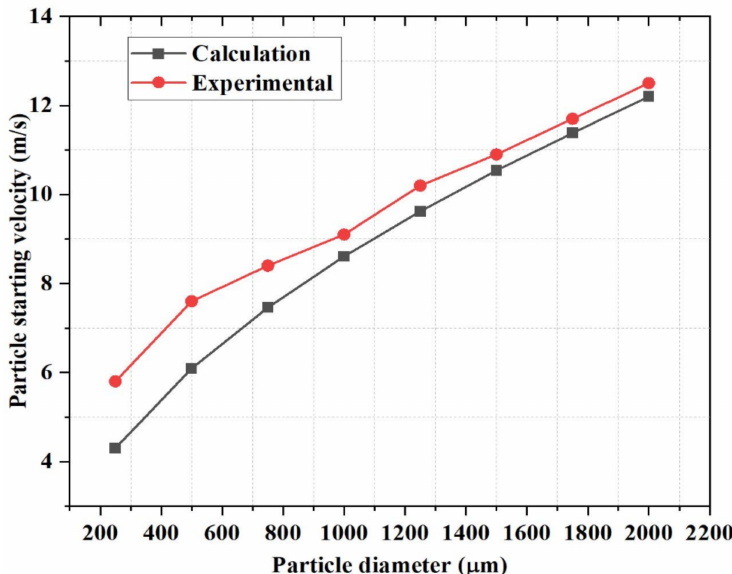
Figure 13. Comparison of the particle starting velocity between calculated and